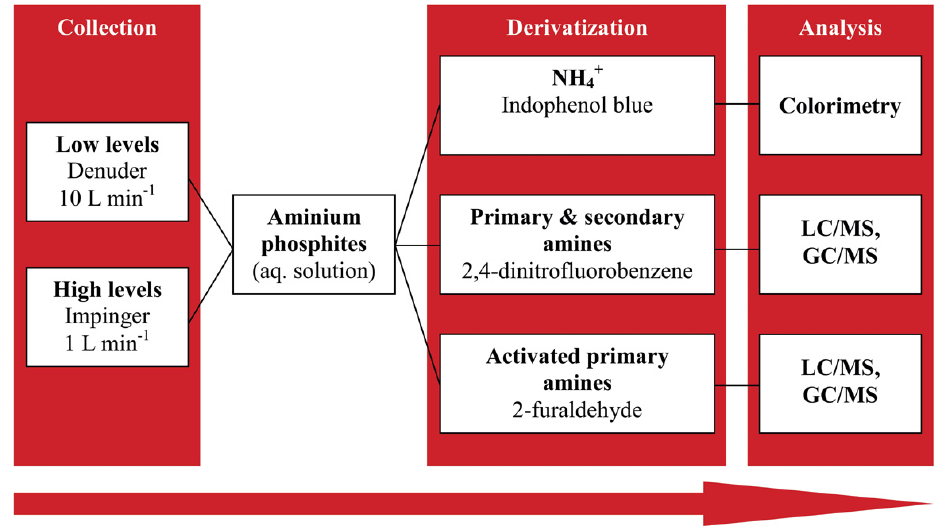
Fig. 1. Schematic representation of the measurement strategy for trace atmospheric